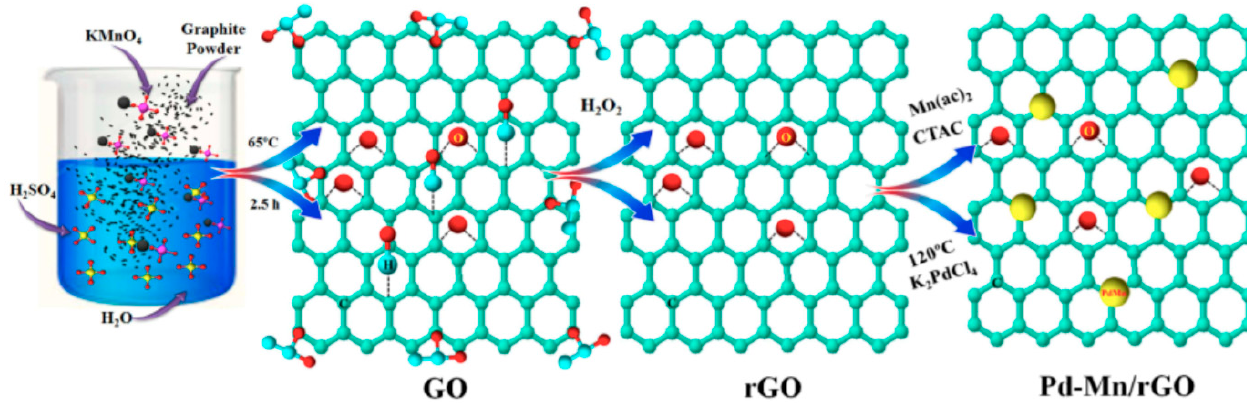
Scheme 6. Schematic diagram presenting the systematic fabrication of Pd-Mn/rGO. Reproduced with permission